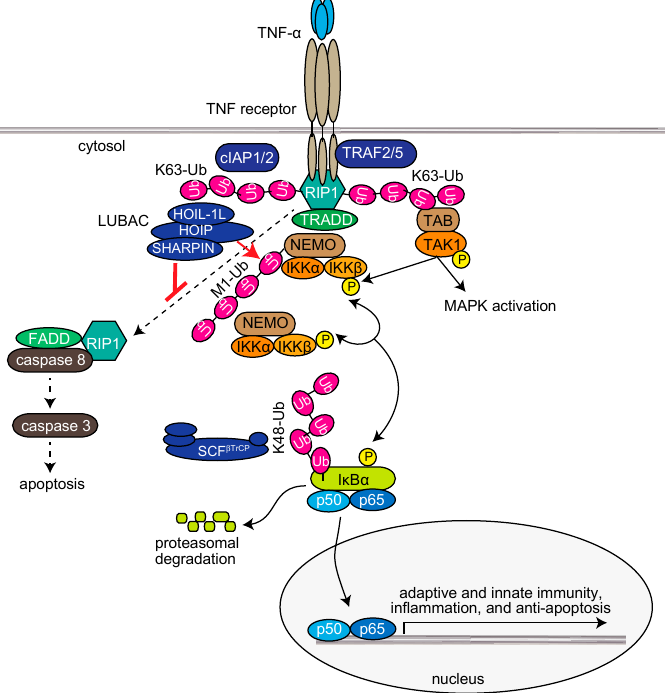
Figure 2. LUBAC-mediated regulation of the TNF- α -induced canonical NF- κ B activation pathway and extrinsic apoptosis pathway.